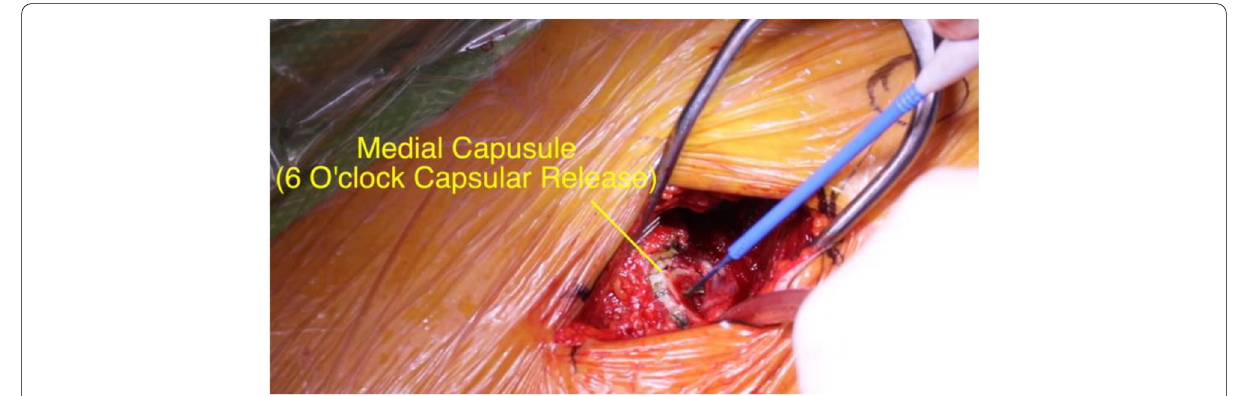
Fig. 6 Medial capsular release. Thickening of the pubofemoral ligament